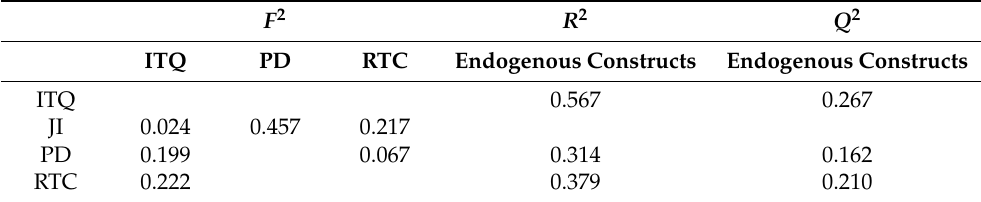
Table 5. Effect size, coefficient of determination, and blindfolding